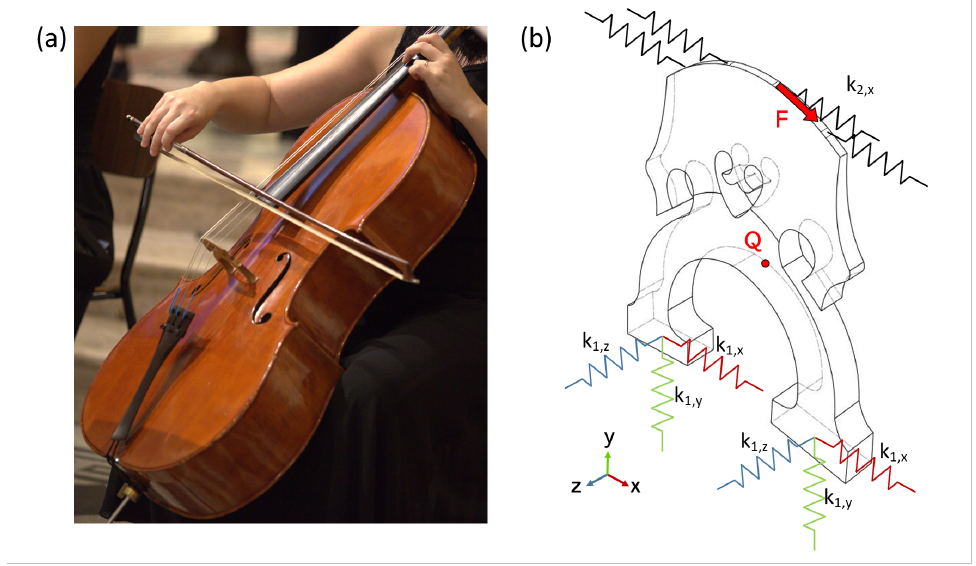
Figure 2. ( a ) Picture of a cellist playing the D string sul tasto , meaning that the bow is near the fingerboard. Ideally, when bowing the instrument, the player applies a force F perpendicular to the string. ( b ) Schematic representation of spring locations used as boundary conditions. In addition, the figure shows the location of point Q and the force vector F, used for the FRF. The figure shows the Normal Model but is valid for all